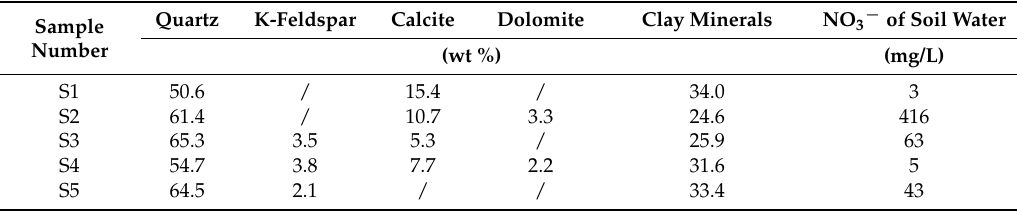
Table 2. Mineral compositions of soil samples in the JSB